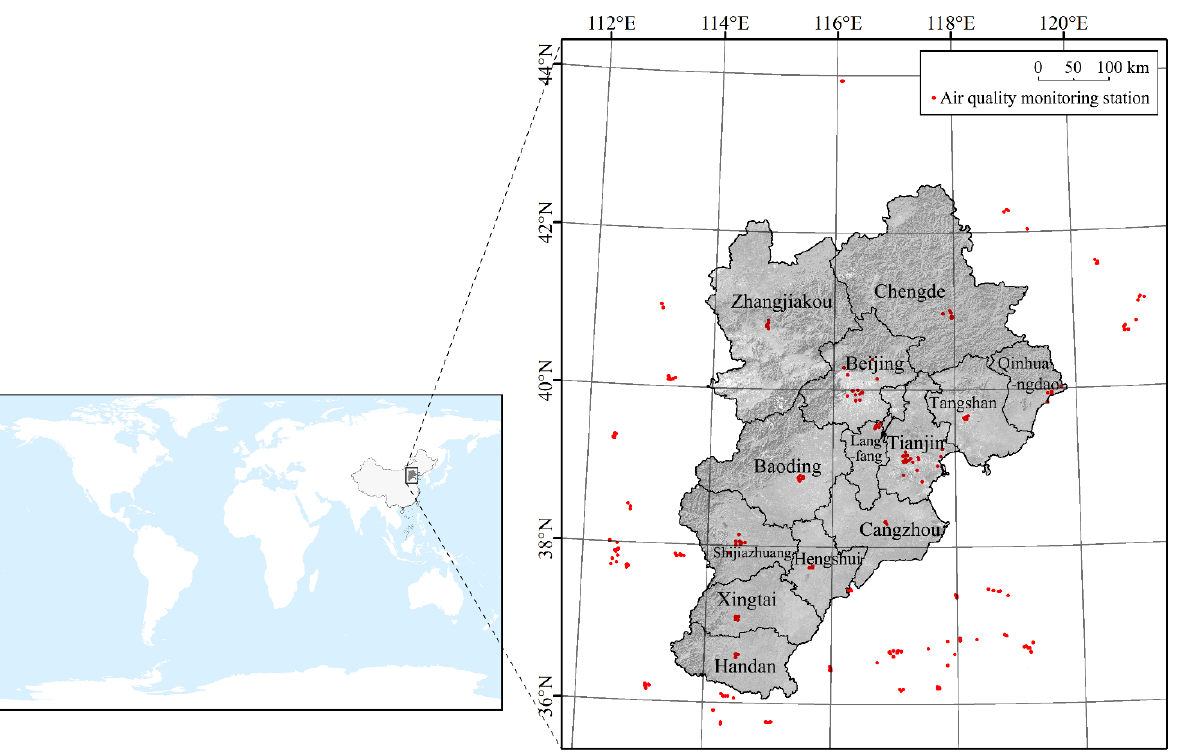
Figure 1. Geographical location of the study area and air quality monitoring stations. Table 1. Grade divisions of the PM concentration and PM 2.5 /PM 10 ratio introducing intermediate